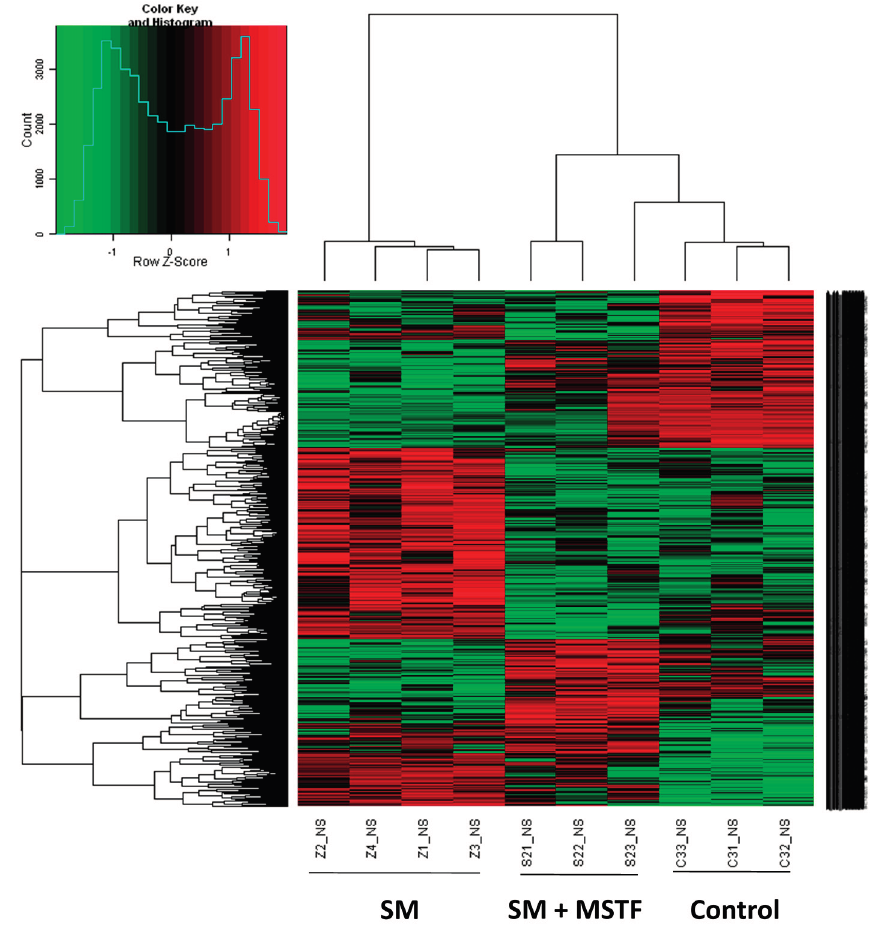
Figure 3. Hierarchical cluster analysis of individual rats according to the profile of gene expression examined. The whole genome microarray was conducted on rat liver tissues 24 h after the application of SM. Then, 4869 transcripts (probe sets) were organized by hierarchical clustering based on overall similarity in expression patterns. Red represents relative expression greater than the median expression level across all samples, and green represents an expression level lower than the median. Black indicates intermediate expression. Rats from the same treatment group are the closest. The control group is close to the SM + MSTF group treated with MSTF (120 mg/kg) 1 h after SM treatment and clearly separate from the SM-only-treated